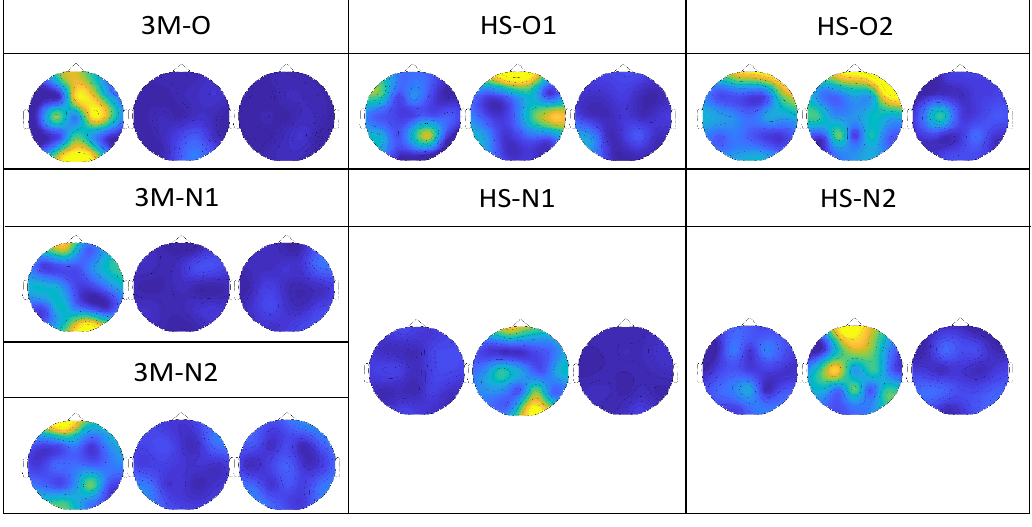
Figure 4. Topoplot images that report the power spectrum distribution of one of the typical trials for each infant. Each of the three topoplots refers to an analysed bandwidth: 0.01–4 Hz (left), 4–8 Hz (middle) and 8–12 Hz (right). The scale was normalized between 0 and 1 (0 = intense blue, 1 = intense yellow) for all subjects and is not shown for convenience. The data disposition resembles that of Figure 1. For patients with 3M syndrome (left column), the left topoplot (0.01–4 Hz) carried most of the power; for healthy subjects (middle and right columns), most of the power was concentrated in the middle topoplot (4–8 Hz). For all subjects, the right topoplot (8–12 Hz) contained negligible power with respect to the lower frequency windows. Table 3. ROI Analytic evaluation.